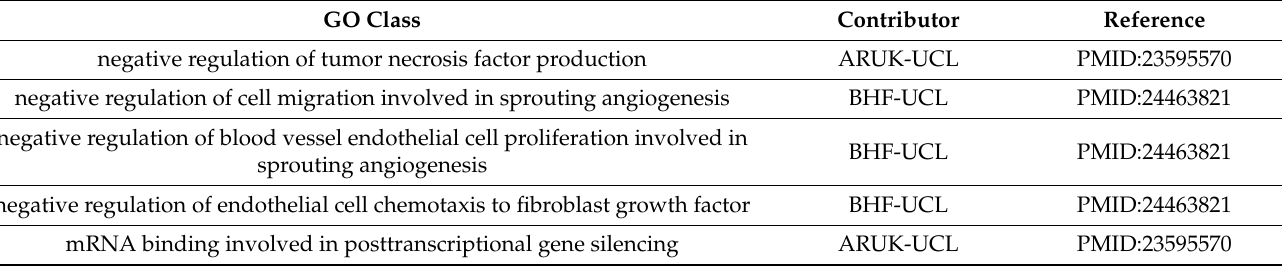
Table 6. Genes and gene products associated with GO terms of miR-149-5p extracted from AmiGO